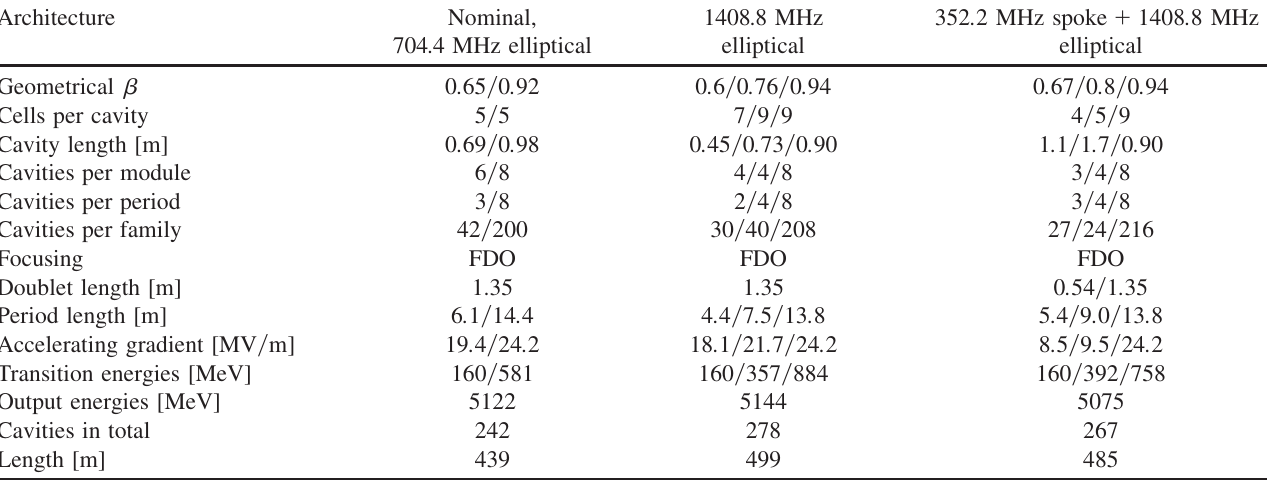
TABLE IV. Lattice data of three possible SPL architectures.